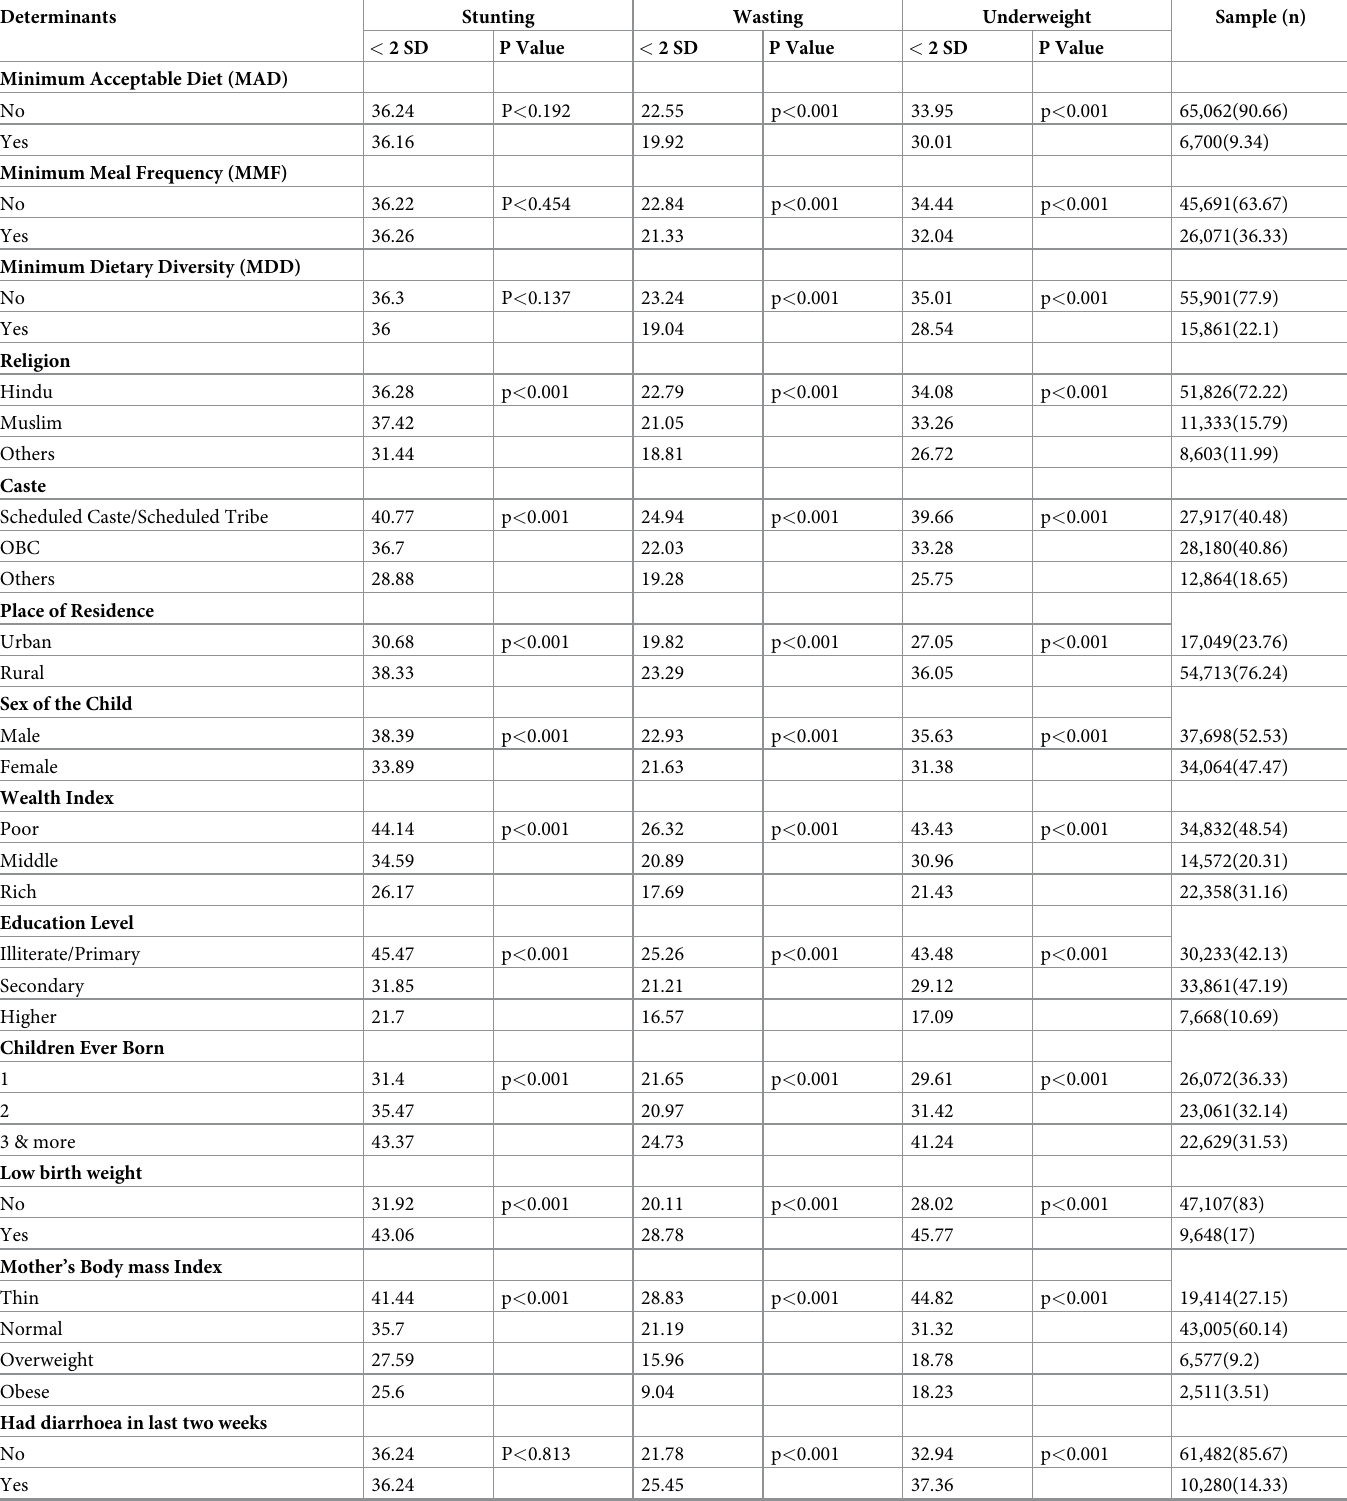
Table 1. Prevalence of malnutrition by background characteristics, India, 2015–16. Determinants Stunting Wasting